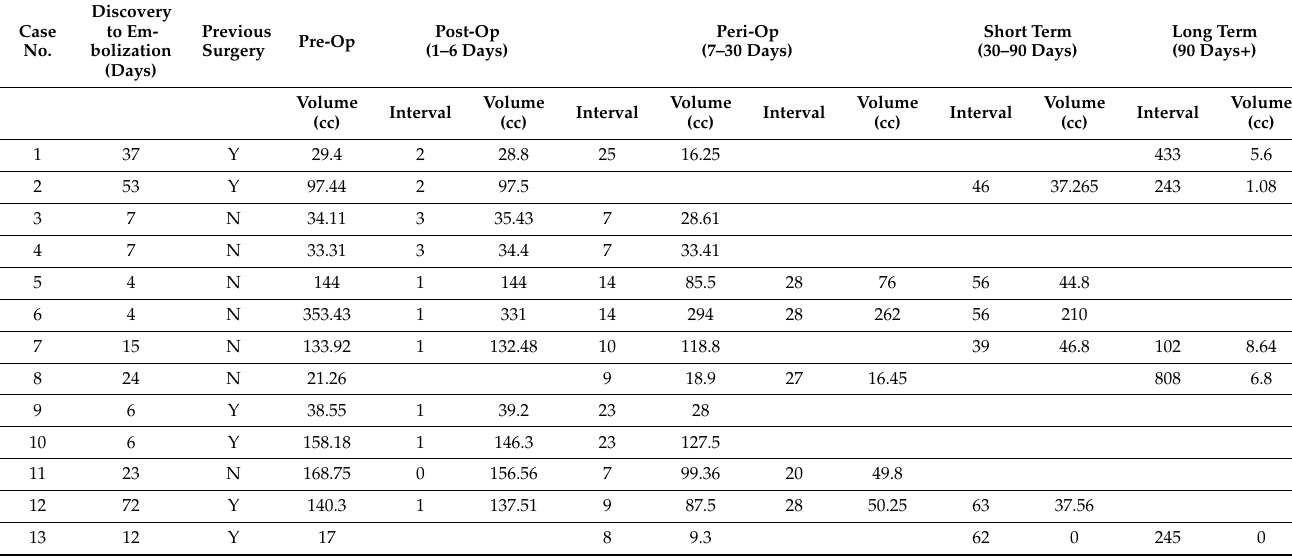
Table 2. Procedural and Radiological